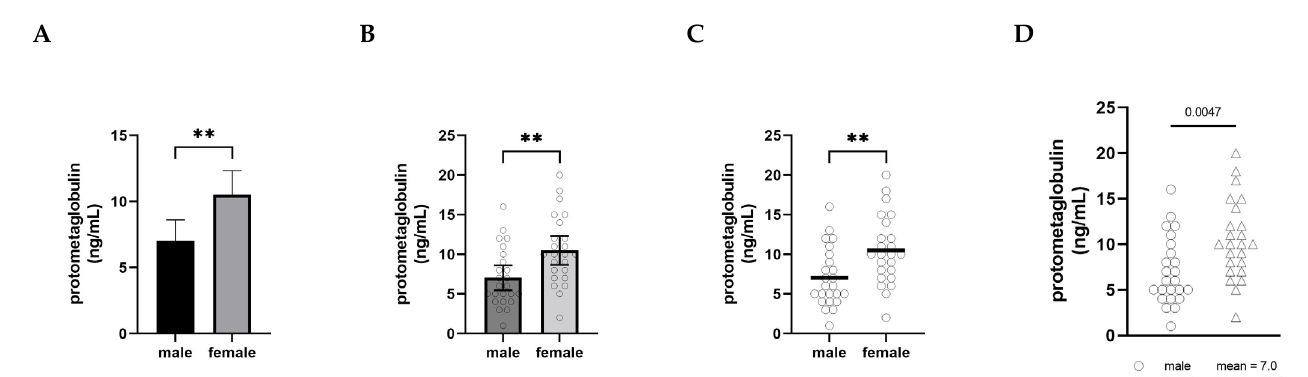
Figure 1. Serum levels of a fictional protein, protometaglobulin, in male and female mice. Panels ( A – D ) all depict the same fictional data using different visualization approaches. ( A ) is a conventional bar graph showing mean ± 95% confidence interval; ( B ) is a bar graph also showing mean ± 95% CI overlaid with a scatter plot with a dot representing each individual animal; ( C ) dispenses with the bars and confidence intervals, showing the scatter plots with a horizontal bar indicating the mean; and ( D ) shows the scatter plots only, with the means written as text beside the legend. n = 24 for each group. Groups were compared using an unpaired t -test; ** indicates p < 0.01.